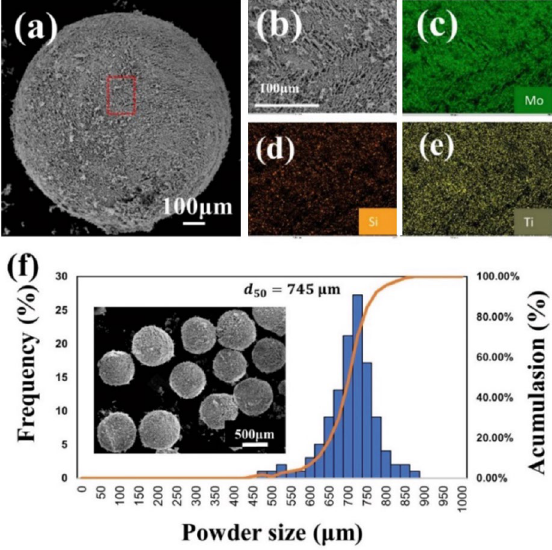
Figure 8. ( a ) SEM images of Mo-Si-MoB-TiC particles by FD-POEM; ( b – e ) the enlarged area marked in red box in ( a ) and corresponding EDS mappings; ( f ) the size distribution and low-magnification SEM image of Mo-Si-MoB-TiC particles.